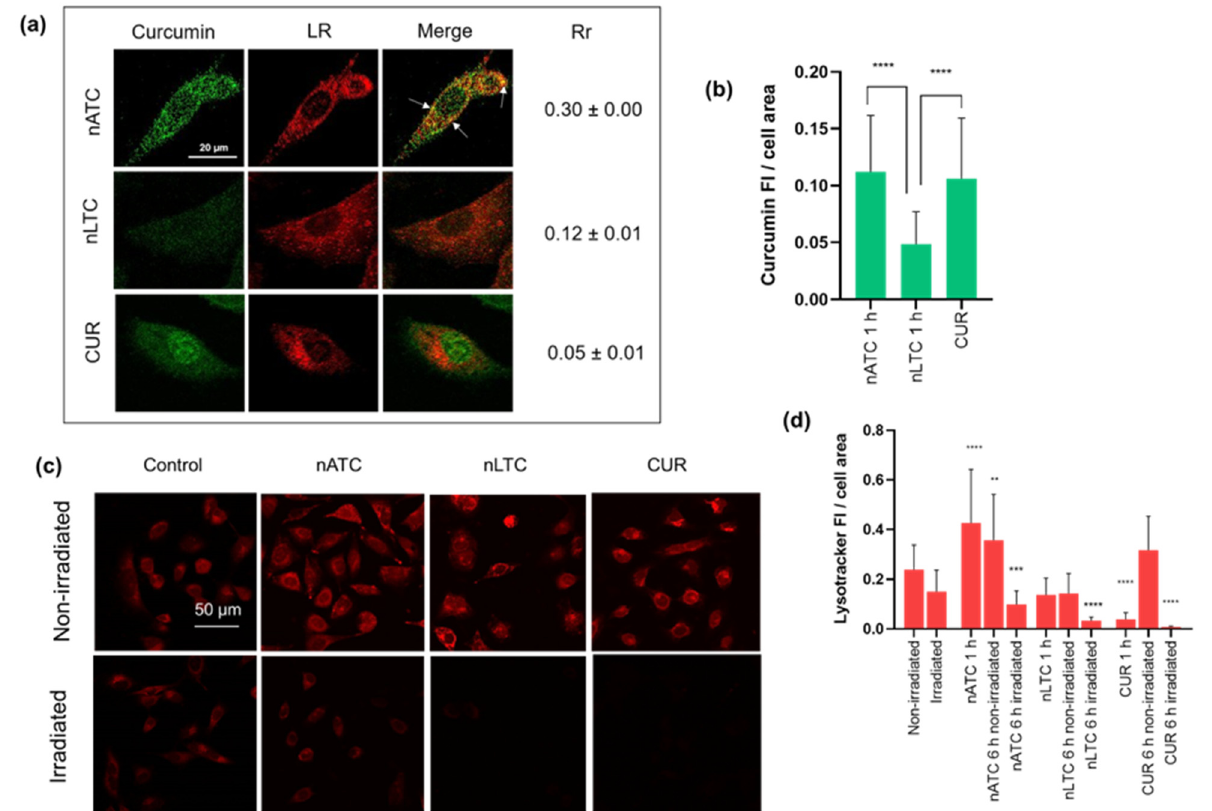
Figure 6. A549 cellular uptake of CUR and lysosomal damage. ( a ) Confocal microscopy images of non-irradiated nATC, nLTC, and CUR after 1 incubation. Green dots represent CUR, red dots represent Lysotracker Red (LR). Pearson’s coefficient (Rr) at 1 h incubation. White arrows indicate yellow dots of colocalization. ( b ) CUR fluorescence intensity inside the cells after 1 h incubation. Significant differences between formulations were determined using a one-way ANOVA followed by Dunnet’s test, **** p < 0.0001. ( c ) Fluorescence images of LR after 6 h incubation with irradiated or non-irradiated nATC, nLTC, and CUR. ( d ) Lysotracker Red (LR) fluorescence intensity inside the cells after 6 h incubation. Significant differences between formulations were determined using a one-way ANOVA followed by Dunnet’s test, ** p < 0.01; *** p < 0.001; **** p < 0.0001.